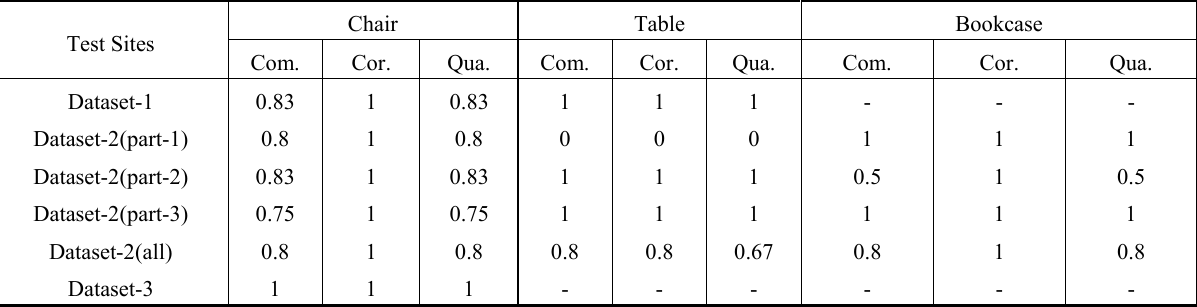
Table 4. Quantitative results of the